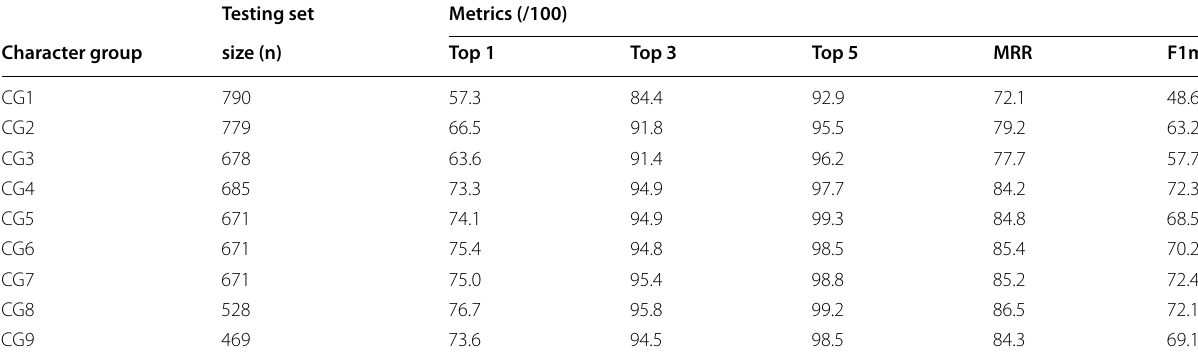
In these results, neither the continent filter nor second pass is applied, and collections without recorded data for at most one character are permitted. The optimization method is AdamW and the network shape is one hidden layer with a ReLU activation function. In this and subsequent results tables, the final five columns refer to the Top 1, Top 3, Top 5, Mean Reciprocal Rank and macro F1 metrics respectively, all scaled to give a score out of 100, which would represent perfect prediction